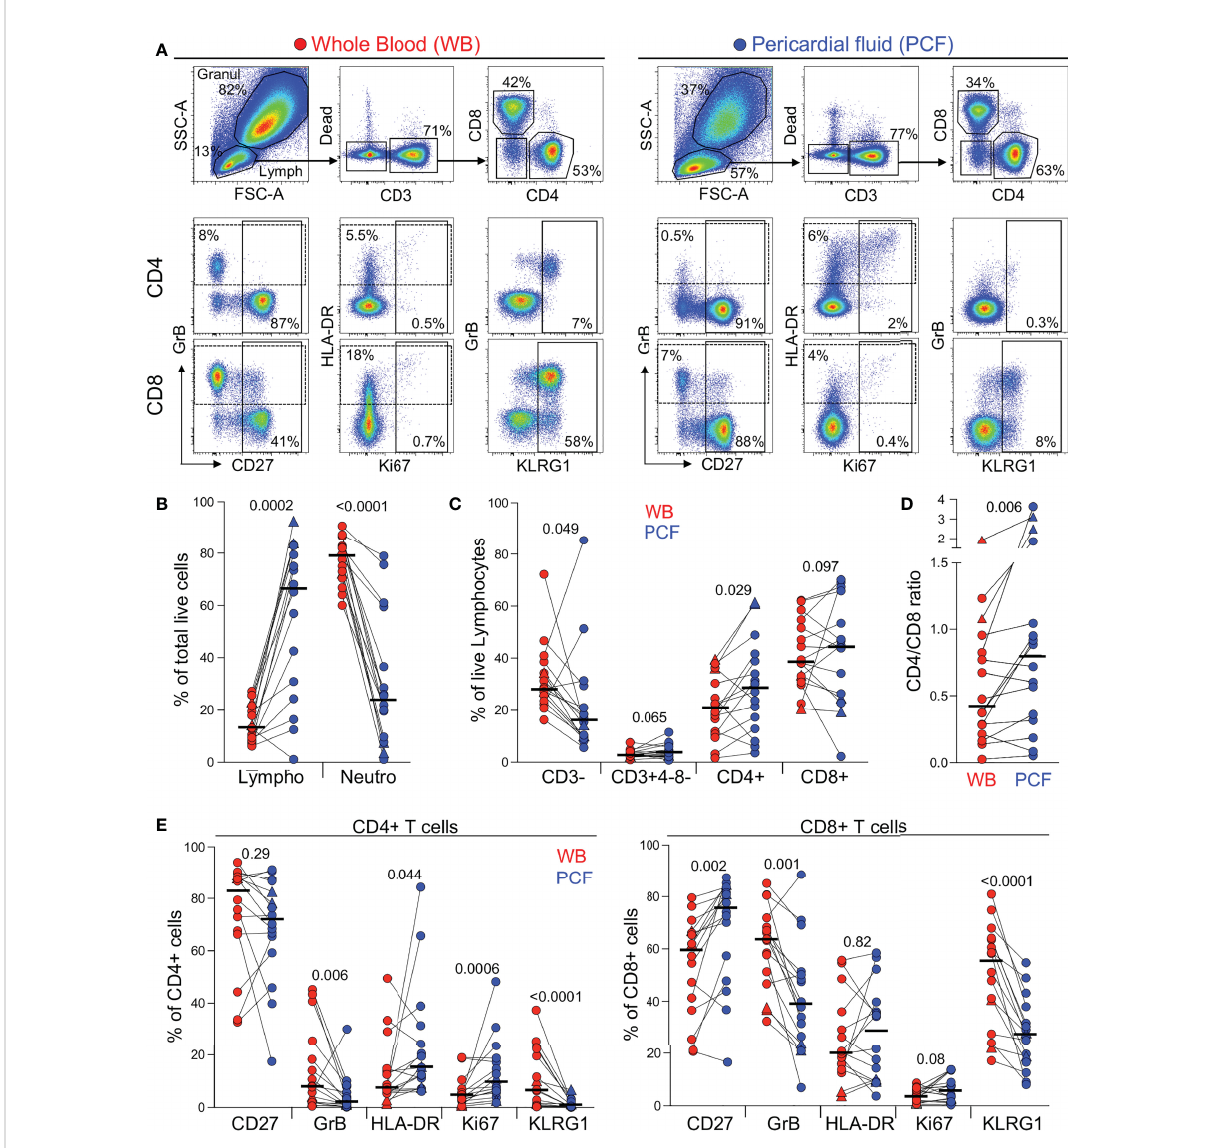
FIGURE 1 Comparison of the distribution of immune cells in whole blood and pericardial fl uid (PCF) in patients with pericarditis. (A) Representative example of the distribution and phenotype of T cells in whole blood (red) and PCF (blue) using fl ow cytometry. (B) Proportion of lymphocyte (Lympho) and neutrophils (Neutro) de fi ned according to their FSC/SSC pro fi le and expressed as a percentage of total live cells in patients with pericarditis (n = 16). Triangles depict HIV-uninfected participants (n = 2). (C) Proportion of CD3-, CD3+CD4-CD8-, CD3+CD4+ and CD3+CD8+ cells, expressed as a percentage of total live lymphocytes. (D) CD4 to CD8 ratio in whole blood and PCF. (E) Expression of CD27, GrB, HLA-DR, Ki67 and KLRG1 in CD4 T cells (left panel) and CD8 T cells (right panel) from whole blood and PCF. Bars represent medians. Statistical comparisons were performed using a Wilcoxon rank